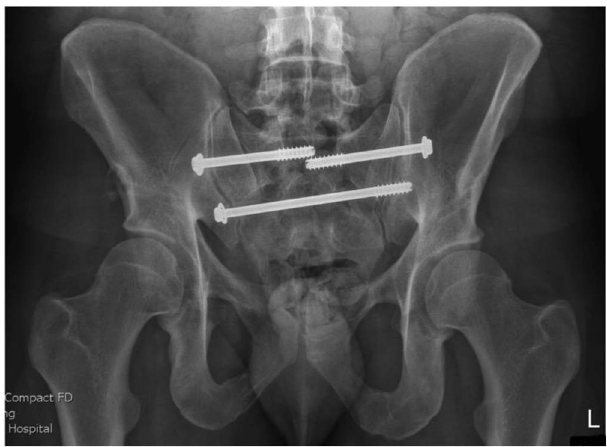
Figure 12. After union and removal of INFIX. Mild right-sided heterotopic ossi fi cation noted. Outlet